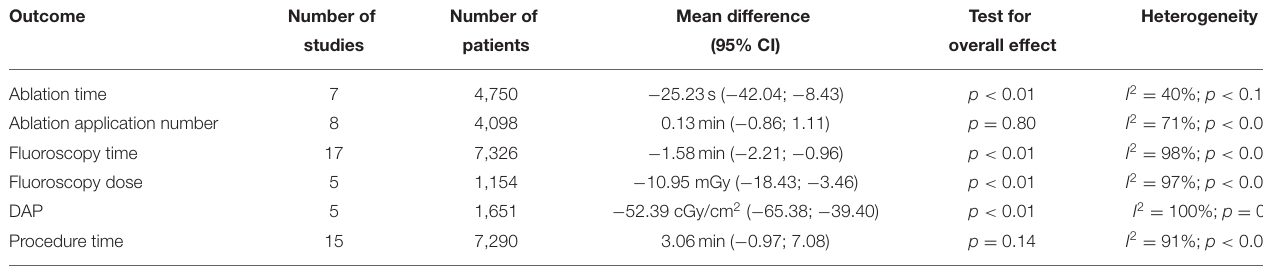
TABLE 2 | Summary of outcomes of secondary endpoints.